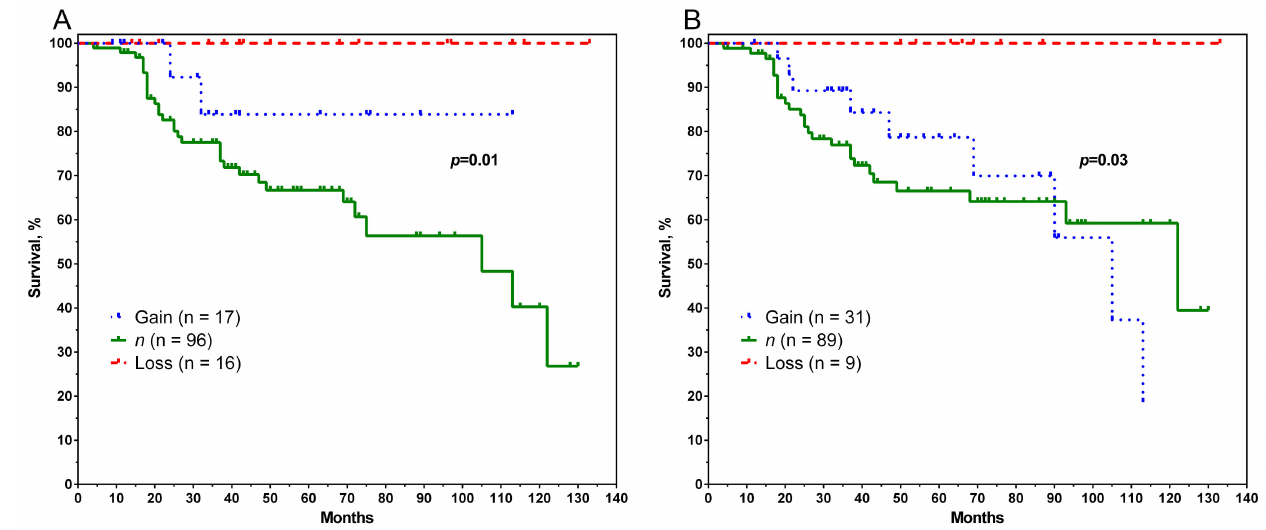
Figure 1. Curves of metastatic-free survival of breast cancer patients depending on the presence of CNA in genes ABCB1 and ABCB4 ( A ), as well as ABCC1 and ABCC6 ( B ). Note: Gain—amplification; Loss—deletion; n —normal number of gene